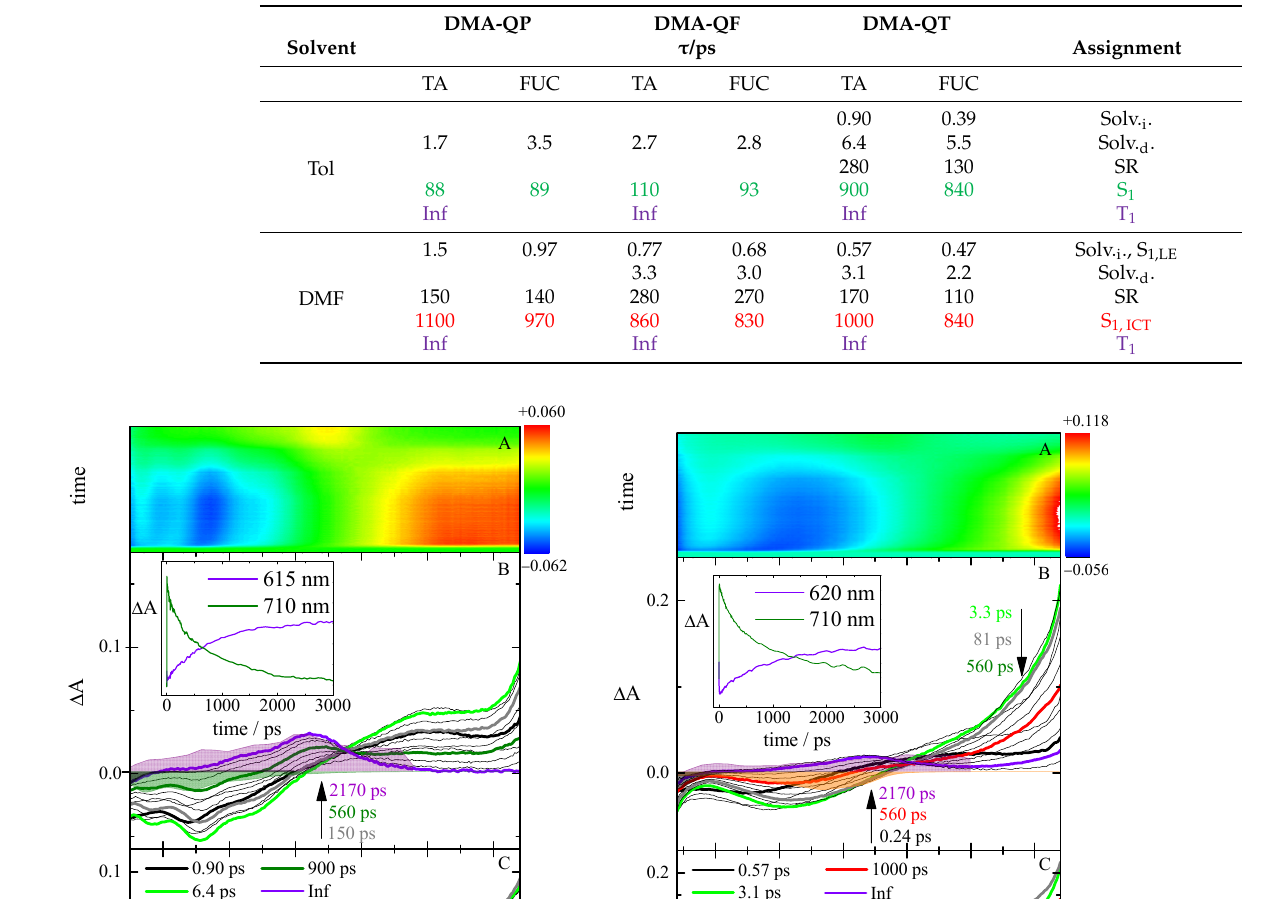
Table 3. Fs-TA and FUC results of global analysis of compounds DMA-QP, DAQF, and DMA-QT in Tol and DMF obtained by exciting at 400 nm.